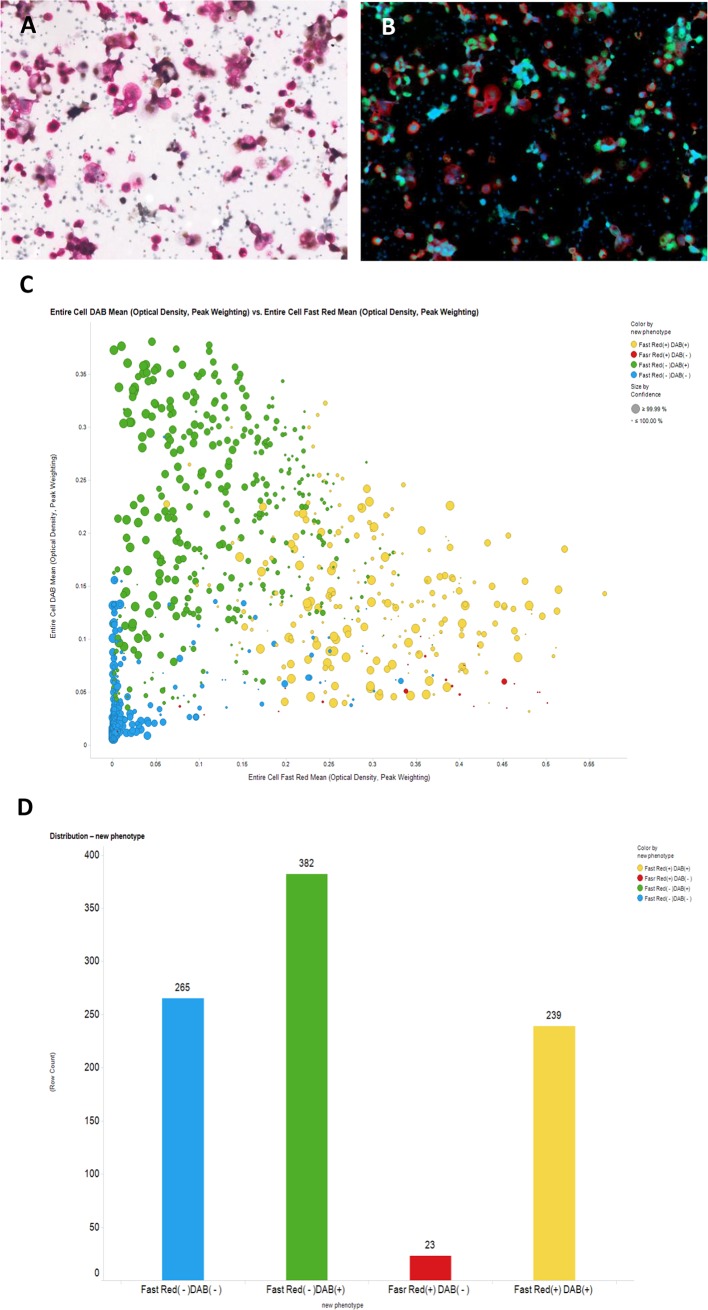
Automatic digitalized interpretation of dual immunocytochemistry.In peritoneal aspirates from patients with ovarian cancer, the suspended cells were very heterogeneous: a mixed population of mesothelial cells and malignant tumor cells. Except for 265 mesothelial cells with dual negative staining (CK7-/PAX8-), all cells were compatible with malignant cells. Approximately 30% of the cells had the typical dual staining (CK7+/PAX8+) pattern.